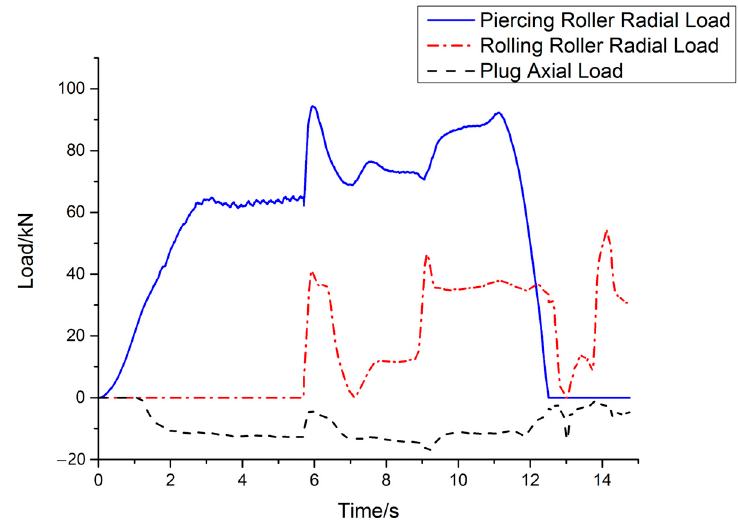
16 of 19 Figure 28. Design of the process for producing hollow axle [37] (Reprinted from ref. [37]). Caoqi et al. [37] creatively put forward tandem flexible skew rolling on the basis of tandem skew rolling, clarified the value range of the tandem flexible skew rolling deflec- tion angle of two sets of rolls and the principles to be followed, simulated the process of